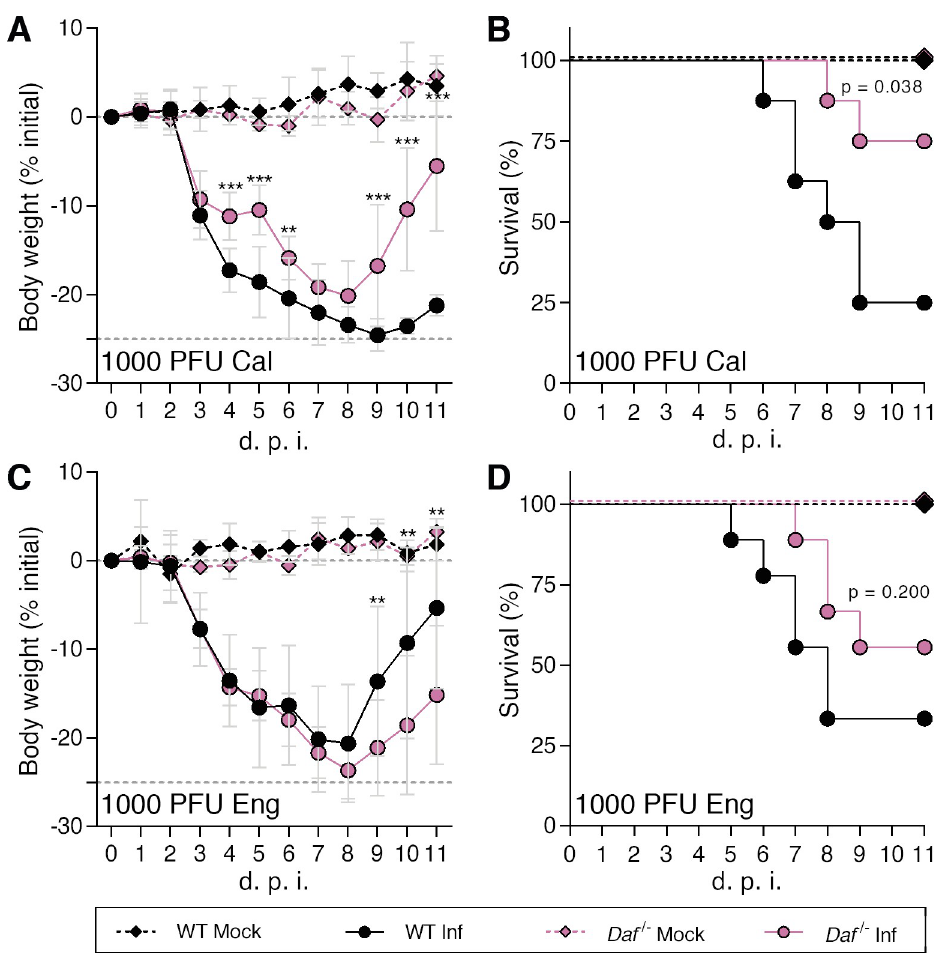
Fig 1. Decay-accelerating factor (DAF) aggravates IAV infection in vivo . A, B : Bodyweight loss ( A ) and mortality ( B ) of C57BL/6J WT or Daf -/- mice infected with 1000 PFU of A/California/7/2009 (Cal) (Inf n = 8; mock n = 3 per group) C, D : Bodyweight loss ( C ) and mortality ( D ) of C57BL/6J WT or Daf -/- mice infected with 1000 PFU of A/ England/195/2009 (Eng) (Inf n = 9 per group; mock n = 5 and n = 4 for WT and Daf -/- respectively). Results are expressed as mean ± sd, statistical analysis detailed in materials and